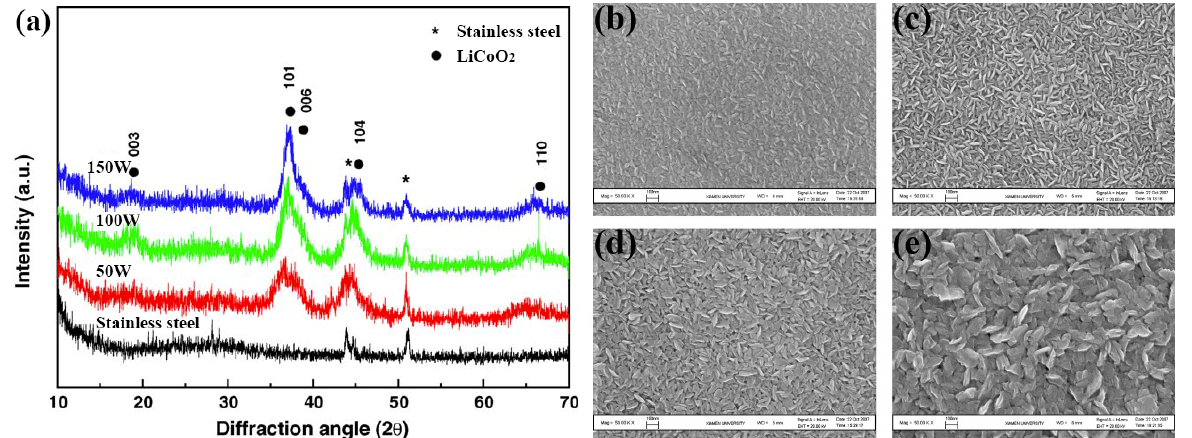
Figure 3. ( a ) XRD patterns of LCO films fabricated at different RF sputtering powers. Reproduced with permission [53]. Copyright 2005, Elsevier. SEM images of as-deposited LCO films on the Pt-substrate fabricated at different RF sputtering powers of ( b ) 80, ( c ) 100, ( d ) 150, and ( e ) 200 W. Reproduced with permission [54]. Copyright 2009, Elsevier.